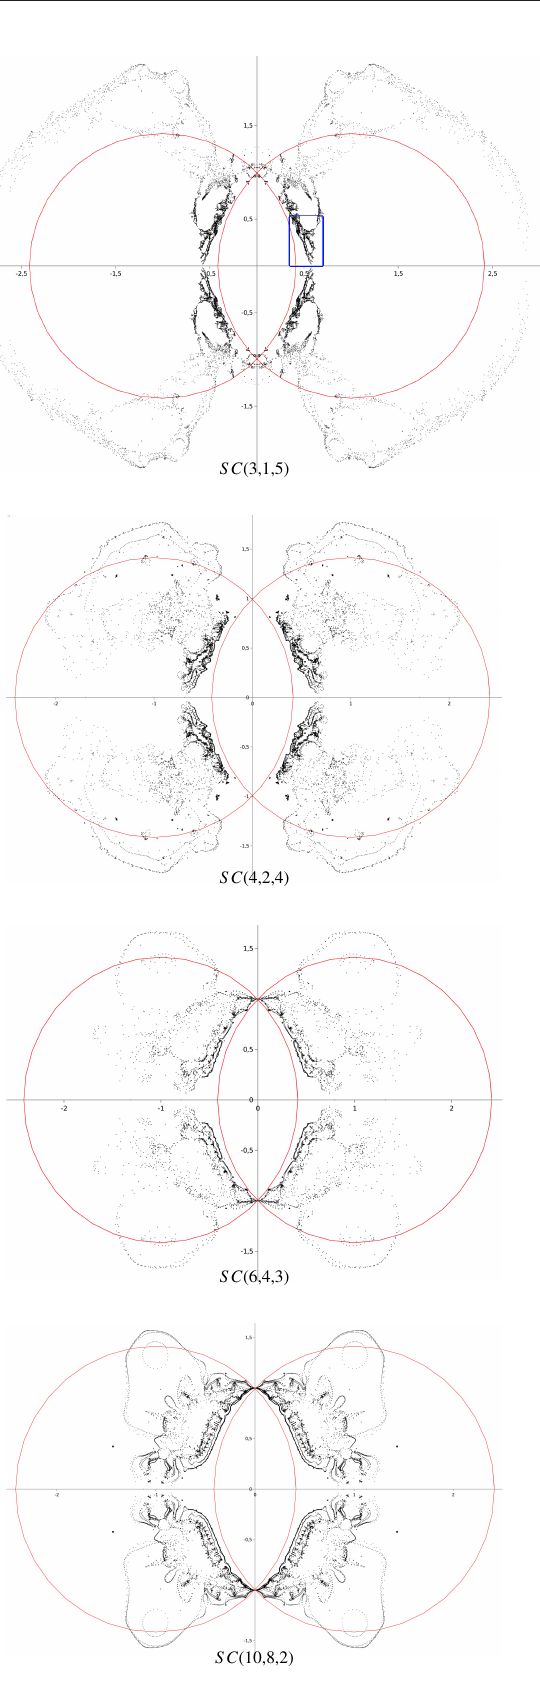
Figure 2. Spectra of the Ising model on SC ( n ; p ; k ) for p = n (cid:0) 2. Figure 3. Spectra of the Ising model on SC ( n ; p ; k ) for p = n (cid:0)